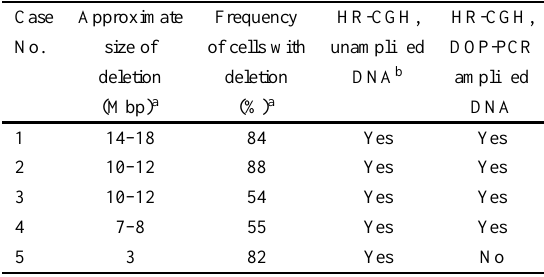
Sensitivity in detection of 11q deletions according to CGH